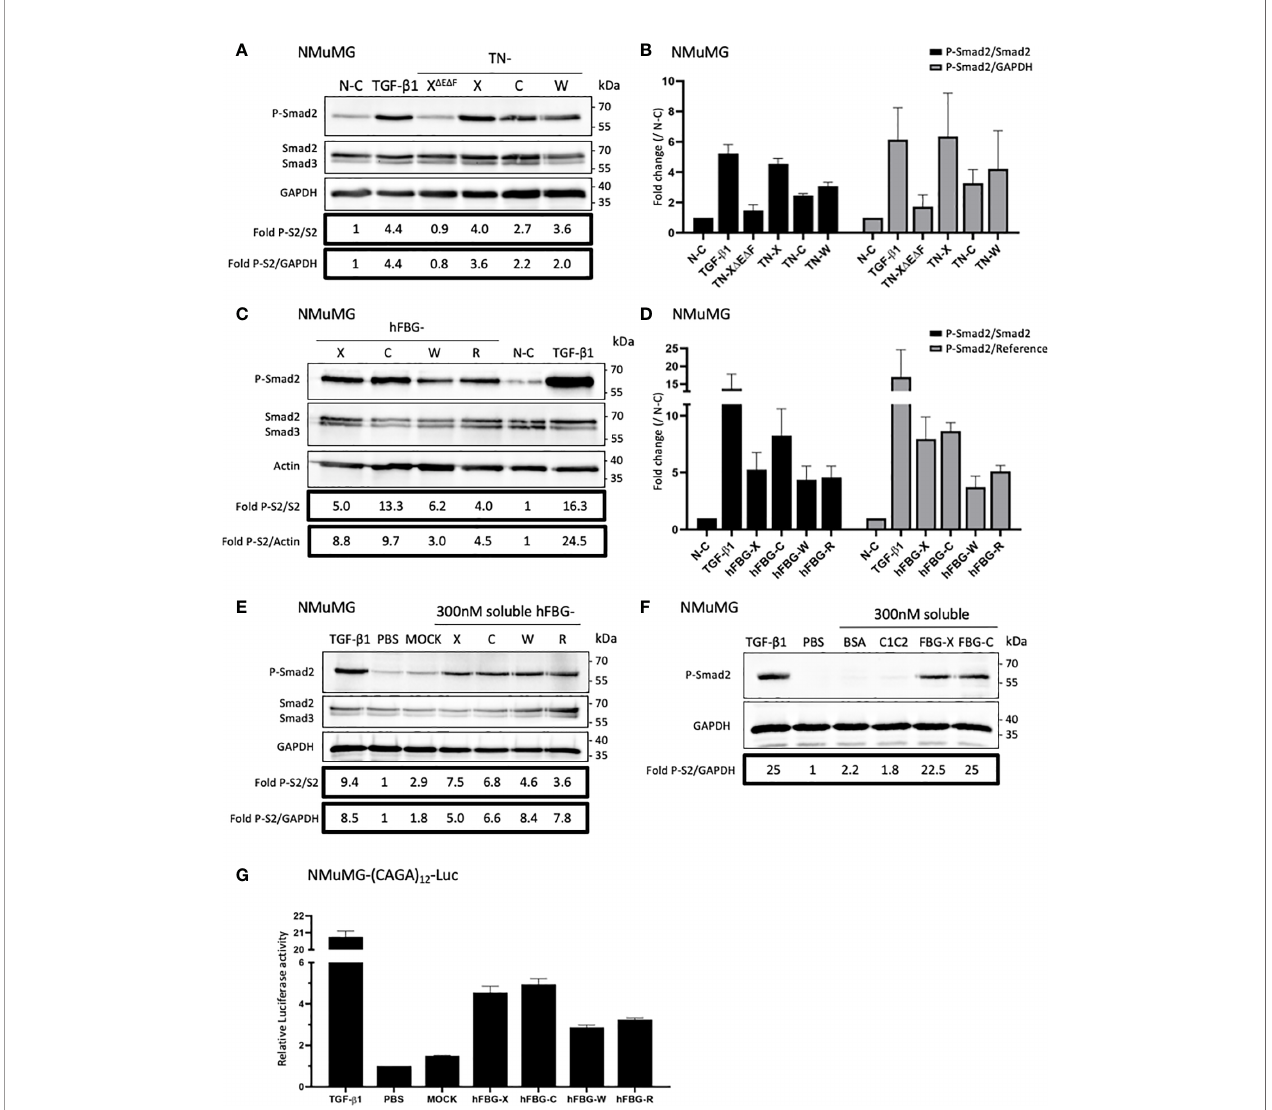
FIGURE 4 | Full-length Tenascins and their respective FBG-like domains stimulate TGF- b /Smad intracellular signaling pathway in epithelial cells. (A) Western Blot analysis showing phosphorylated Smad2 (P-Smad2), total Smad2/3 and GAPDH levels in NMuMG cells cultured for 3h onto control non-coated (N-C) dishes or dishes coated with equimolar quantity (22,2 pmol/cm 2 ) of full-length Tenascins (TN) or central TN-X fragment (TN-X D E D F ), or stimulated with soluble active TGF- b 1 (2 ng/mL). (B) Fold changes of P-Smad2 to total Smad2 levels or to GAPDH levels. Graph shows means ± SD of n = 3 independent experiments. (C) Western Blot analysis showing P-Smad2, total Smad2/3 and Actin levels in NMuMG cultured for 3h onto equimolar quantity of FBG-like domains (333 pmol/cm 2 ) or stimulated with soluble active TGF- b 1 (2 ng/mL). (D) Fold changes of P-Smad2 to total Smad2 levels or to reference protein levels. Graph shows means ± SD of n = 3 independent experiments. (E) Western-blot analysis showing P-Smad2, Smad2/3 and GAPDH levels in NMuMG cells stimulated for 1h in the presence of active TGF- b 1 (2 ng/mL), stimulated or not (PBS) with soluble FBG-like domains (300 nM) or MOCK-CM. “ MOCK-CM ” referred to the conditioned media of MOCK- transfected HEK293 EBNA cells, submitted to Nickel-af fi nity chromatography and eluted from the column as for the FBG-like domains. (F) Immunoblotting analysis showing P-Smad2 and GAPDH levels in NMuMG cells stimulated for 1h in the presence of active TGF- b 1 (2 ng/mL), stimulated or not (PBS) with soluble CUB1CUB2 protein fragment (C1C2), bovine serum Albumin (BSA) or FBG-like domains (300 nM each). (G) Relative Luciferase activity of NMuMG cells transiently transfected with the Smad-responsive (CAGA) 12 -Luc reporter construct and treated for 16h with soluble FBG-like domains (600 nM), MOCK-CM or TGF- b 1 (2 ng/mL). Graph shows one representative result from 3 independent